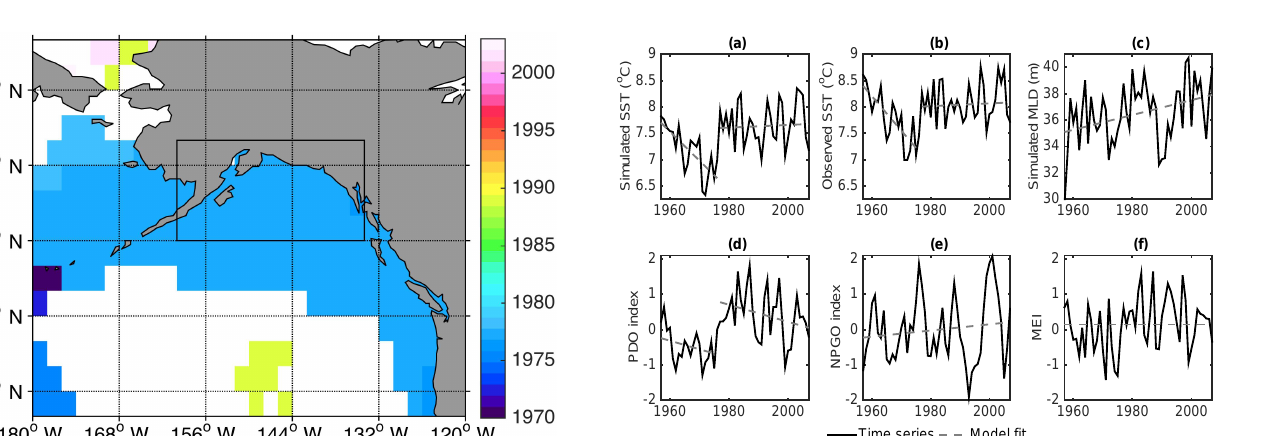
Figure 2. Timing of shift detected in observed sea surface temper- ature in the North Pacific using change-point analysis showing a predominant signal in 1977. White areas indicate where a shift is not significant ( p value>0.05). The black box indicates the Gulf of Alaska region used in this study.